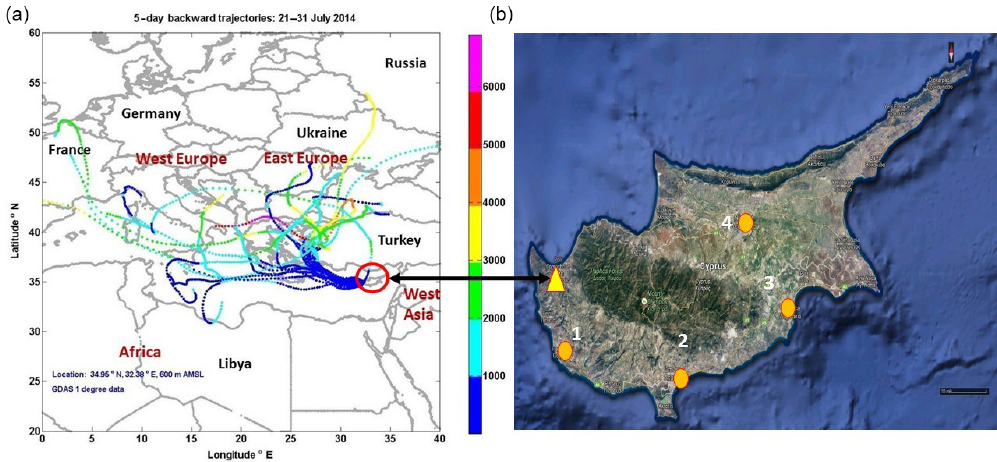
Figure 1. (a) Air masses during CYPHEX; the colour bar represents trajectory height in metres above mean sea level. (b) Map of Cyprus. Measurement site (yellow triangle), cities (circles; 1. Paphos, 2. Limassol, 3. Larnaca, 4.